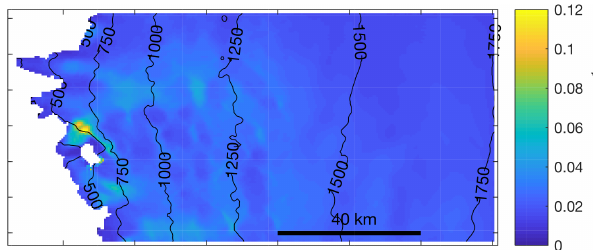
Figure 6. Modelled basal melt rate using basal velocities from lin- ear inversion.